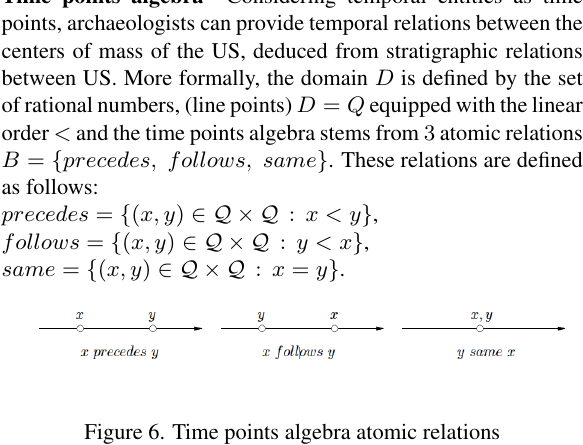
Figure 8. QCN when temporal entities are time